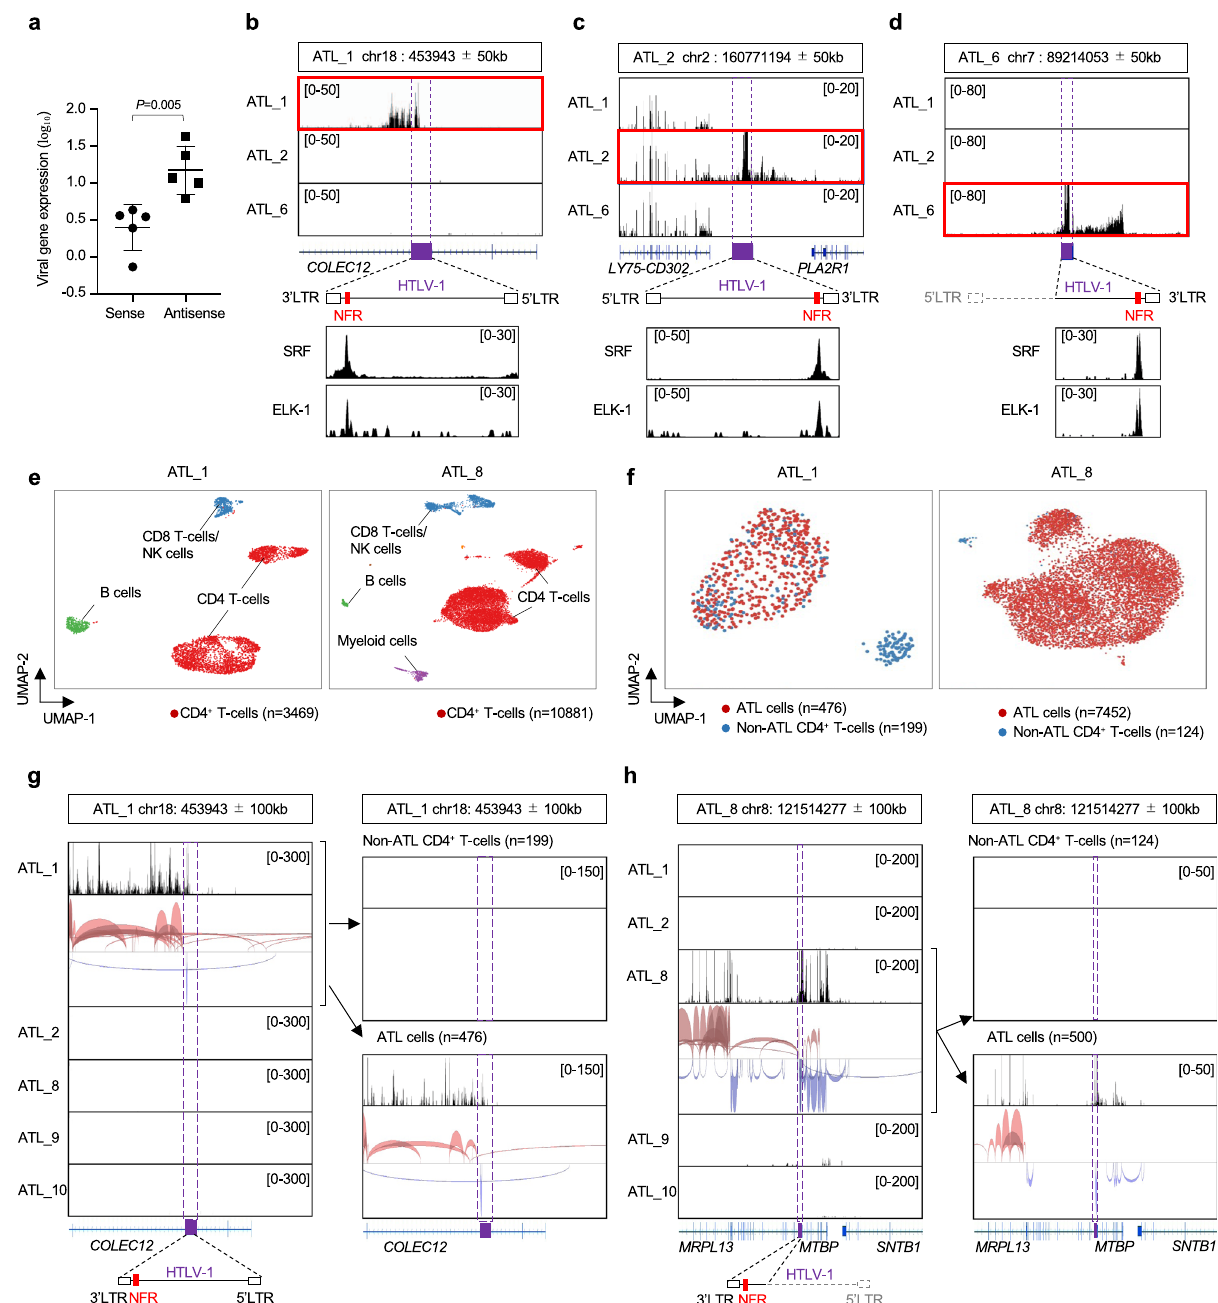
Fig. 7 Transcriptional characterization of the provirus and the fl anking host genomes in freshly isolated PBMCs from infected individuals. a Expression level of sense or antisense proviral transcripts in fresh PBMCs from fi ve ATL patient samples (ATL_1, ATL_2, ATL_5, ATL_6, ATL_7). Data were shown as transcripts per million from bulk mRNA-seq for each case. n = 5 biologically independent samples, mean ± SD. P values are calculated by a two-sided Student ’ s t -test. b – d Visualization of mRNA-seq data of three ATL cases ( b ATL_1, c ATL_2, and d ATL_6) around each proviral IS. Host genes near the IS and direction of HTLV-1 provirus are indicated under mRNA-seq signal images. SRF/ELK-1 ChIP-seq results without HTLV-1 DNA-capture are also shown for each ATL sample. The ATL sample with HTLV-1 IS in the region is highlighted with a red square. e scRNA-seq data of PBMCs from the indicated ATL cases. Cell clusters were annotated by examining the expression pattern of the marker gene for each PBMC subset as described in Methods. f Figures show the distribution of ATL cells and non-ATL CD4 + T-cells for the two ATL cases in ( e ). ATL cells are de fi ned as the T-cells with the most abundant T-cell receptor (TCR). g , h Local transcriptome including viral integration site are visualized by IGV. We obtained scRNA-seq data from fi ve ATL cases. The data shown were regions with viral IS of g ATL_1 and h ATL_8 respectively. Data from all CD4 + T-cells are shown in the left panel. CD4 + T-cells are further divided into non-ATL CD4 + T-cells (right, upper panel) and ATL cells (right, lower panel) based on their TCRs.